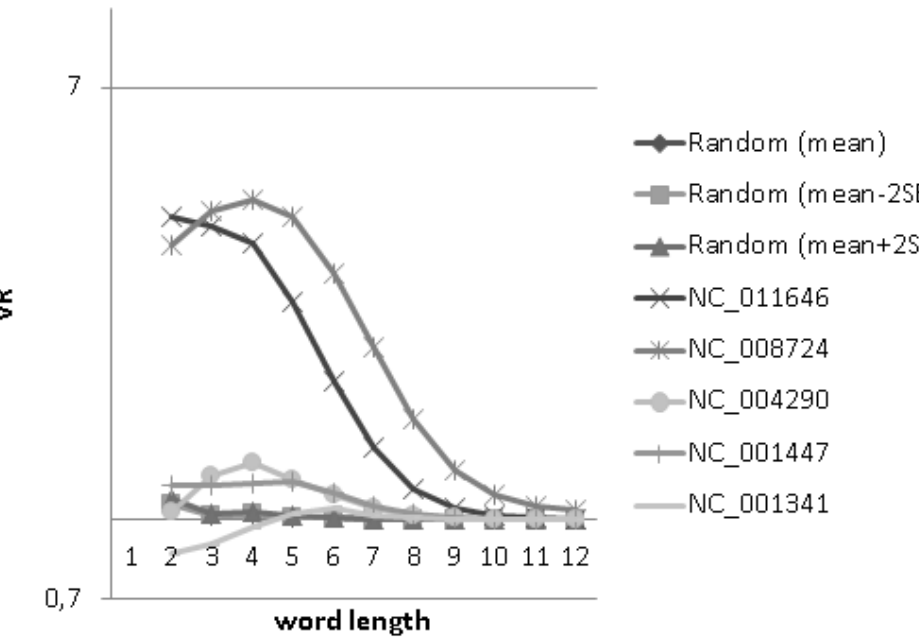
Figure 3: VR values for viruses; random (mean and mean ± 2 × standard error).